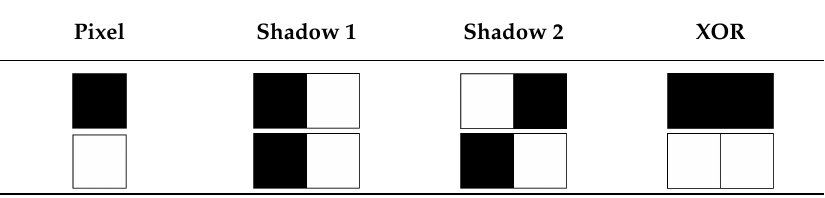
Table 2. The encoding and decoding process of the shadows in a (2, 2)-XVC scheme.